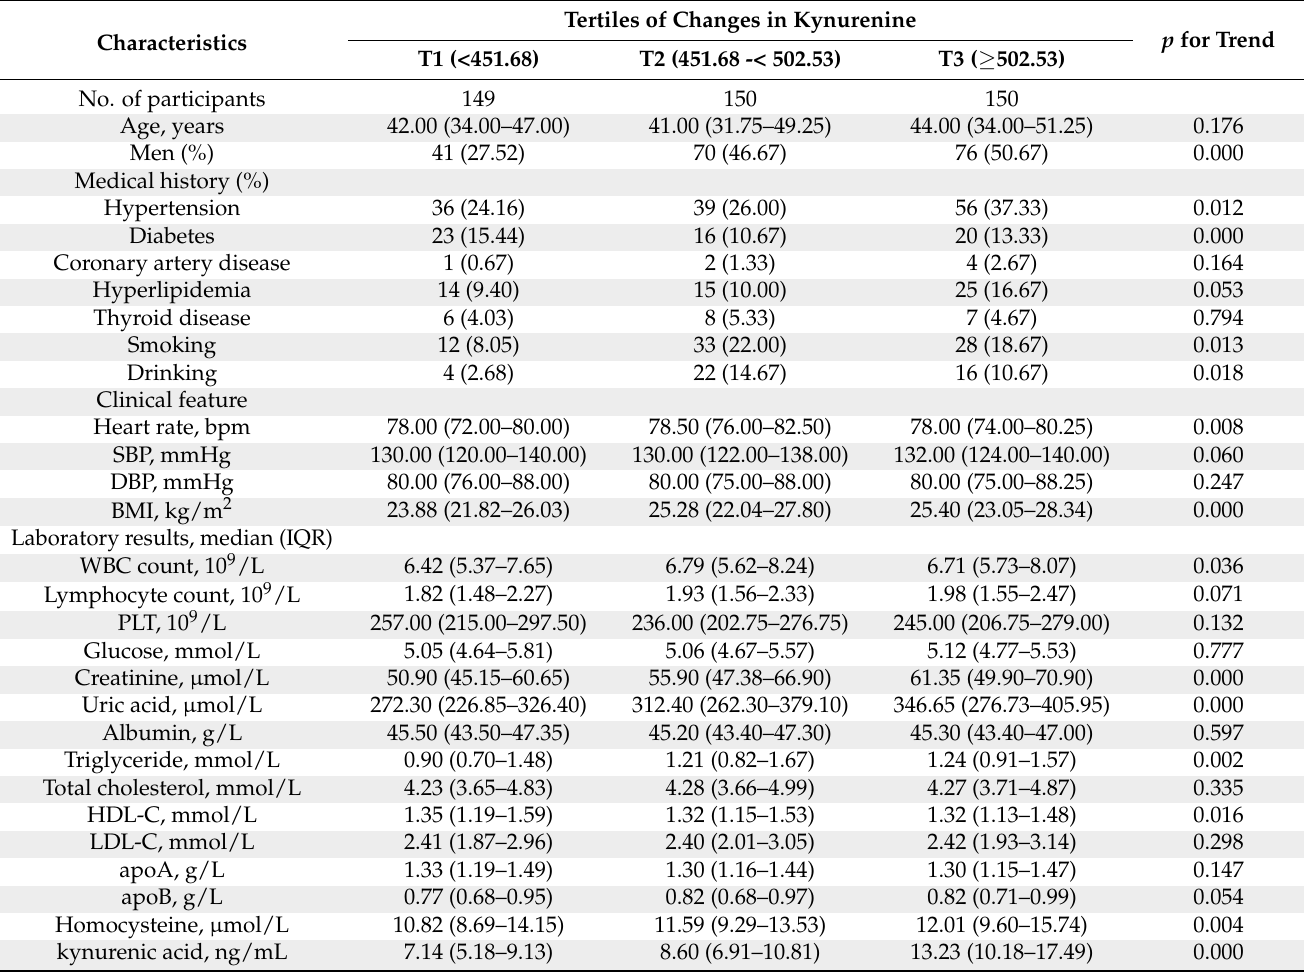
Table 3. Baseline characteristics of participants according to tertiles of changes in